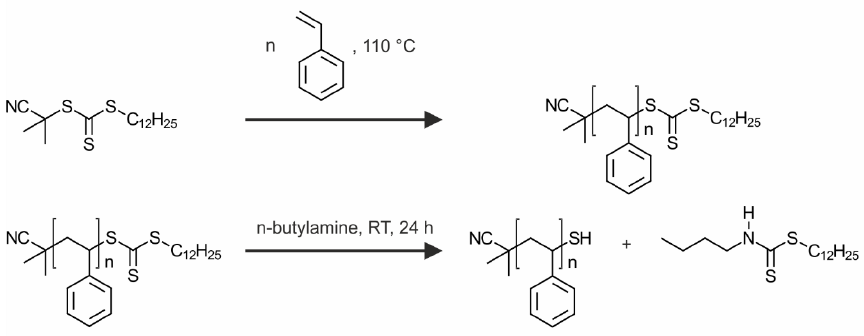
Figure 1. Reaction scheme of the RAFT polymerization ( top ) and the aminolysis to yield a thiol functionalization ( bottom ).